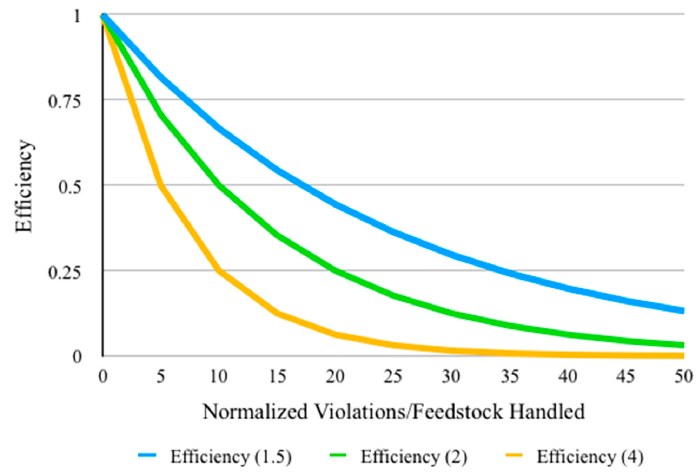
Figure 3. Conversion Efficiency Function Graphs.